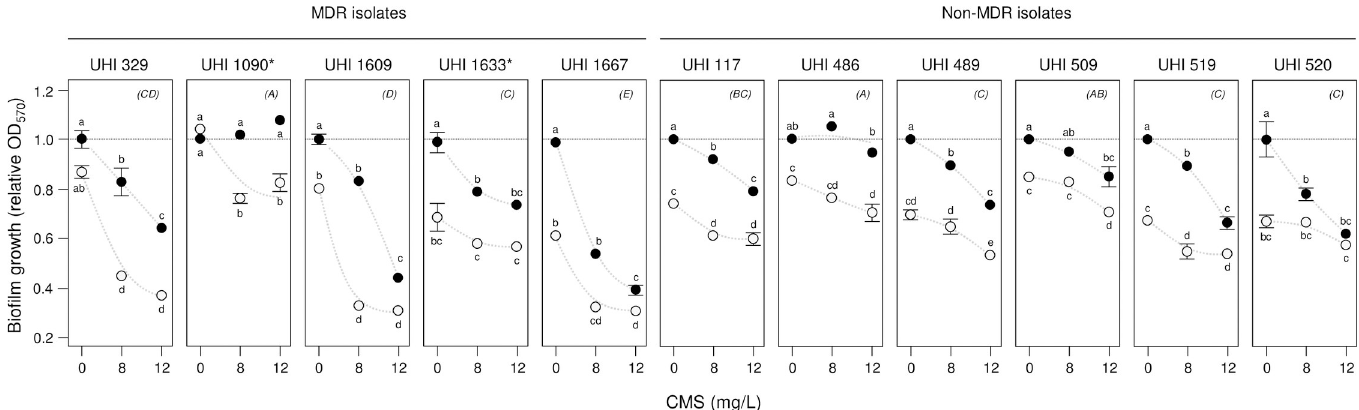
Fig 5. AZM and CMS synergistically inhibit biofilm growth of K . pneumonia hospital strains. The effect of azithromycin (AZM) and colistin methanesulfonate (CMS) on biofilm growth of multiple-drug resistant (MDR) and non-MDR K . pneumonia Ukrainian Hospital Isolate (UHI) strains was investigated using biofilm assays and with optical density (OD 570 ) measurements after 24 h incubation. Mean relative OD 570 ± SE ( n = 3) is shown, with no-AZM (control) treatments indicated by dark circles and 9 mg/L AZM treatments by light circles, (trends are suggested by dashed curves). Means not connected by the same letters are significantly different (LSMeans Differences Tukey HSD, alpha = 0.05 for individual UHI strain mixed-effects models of relative OD 570 ). Strains not connected by the same letters indicated in parentheses in the top- right of each panel are significantly different (LSMeans Differences Tukey HSD, alpha = 0.05 for combined UHI strain mixed-effects model of relative OD 570 ). � , UHI 1090 and UHI 1633 were found to be resistant to COL in the broth dilution